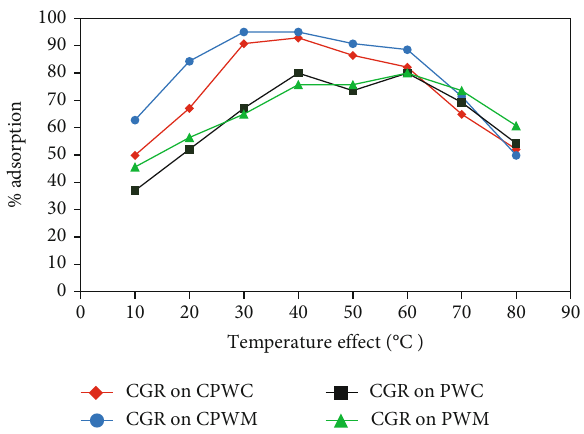
Figure 11: Optimization the e ff ect of temperature.